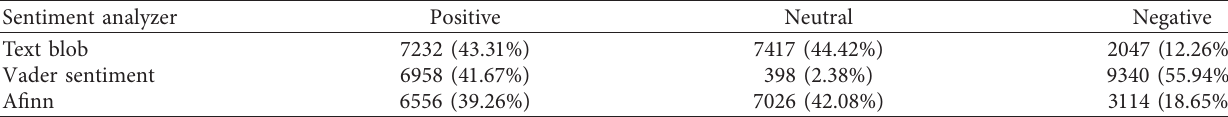
Table 2: Tweets with target